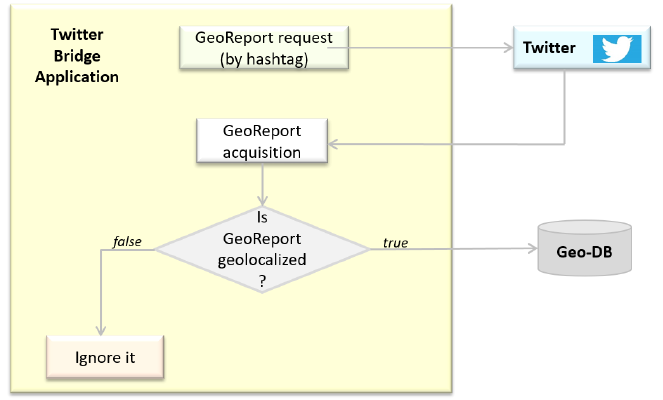
Figure 5. Functional architecture of the